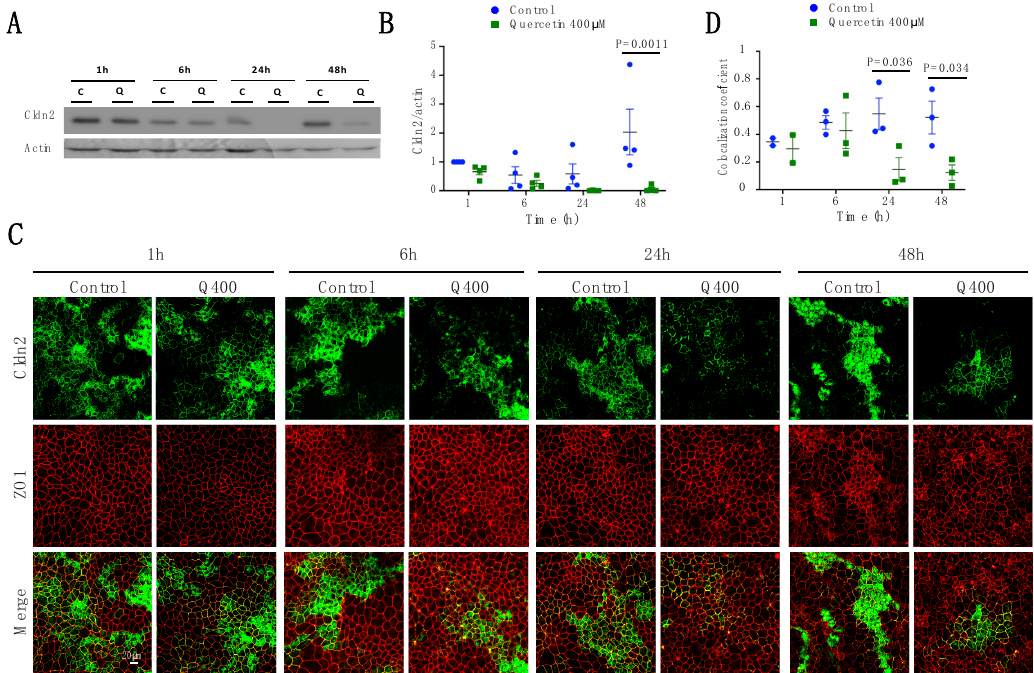
Figure 3. Analysis of Cldn2 expression and localization in MDCK II cells following quercetin treatment. ( A ) Western blot analysis of Cldn2 expression in cell lysates from control and 400 µ M quercetin-treated MDCK II cells. Actin was used as a loading control. ( B ) Densitometry measurements of Cldn2 and actin intensity on western blot were normalized to control at 1 h. Normalized Cldn2 expression relative to normalized actin is plotted (P int = 0.052; P time = 0.096; P treat = 0.0021). ( C ) Immunofluorescence of control and 400 µ M of quercetin-treated MDCK II cells at 1, 6, 24, and 48 h. Cldn2 is shown in green and ZO1 is shown in red. ( D ) Localization of claudin at the tight junction was assessed by determining the amount of ZO1 that co-localized with claudin expression (P int = 0.15; P time = 0.46; P treat = 0.0055). For all graphs, each point corresponds to an independent experiment; mean and SEM are shown. C = Control and Q = Quercetin. Scale bar, 20 µm.